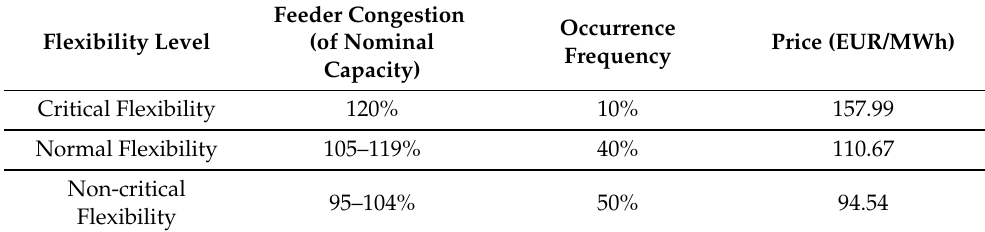
Table 1. Flexibility event